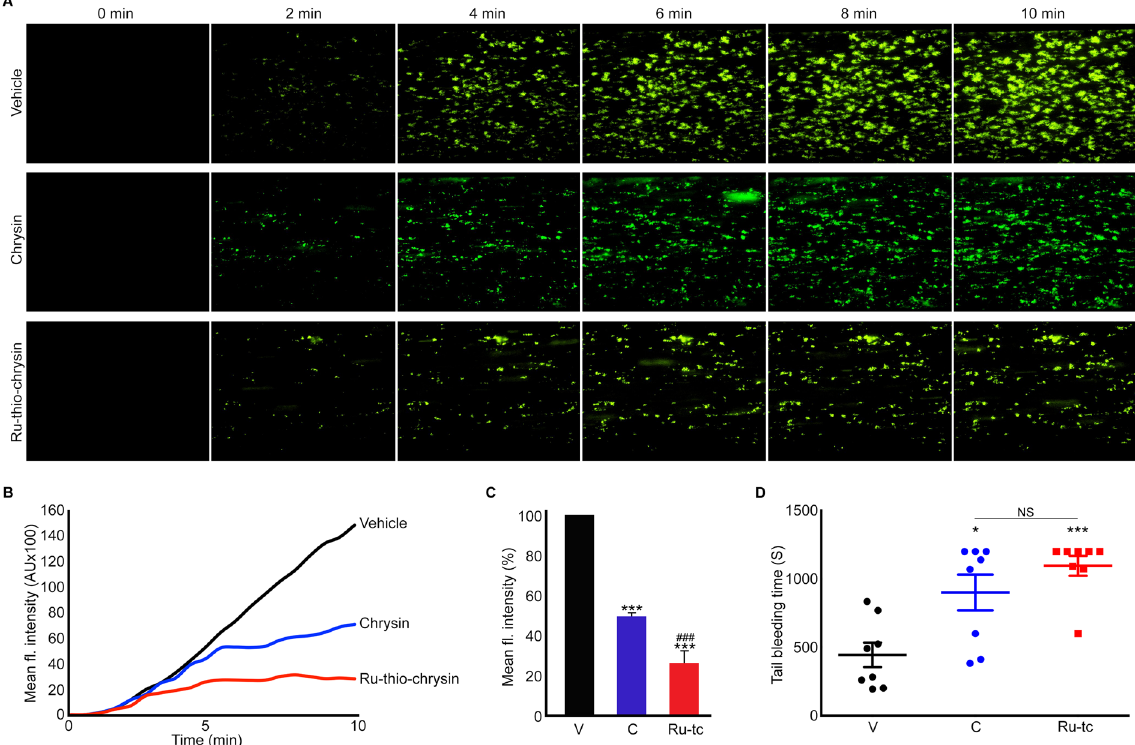
Figure 7. Differential effects of chrysin and Ru-thio-chrysin in the modulation of thrombus formation under arterial flow conditions and haemostasis in mice. DiOC6-labelled human whole blood was treated with vehicle control [0.1% (v/v) DMSO] or 100 μ M chrysin or Ru-thio-chrysin for 5 minutes prior to the perfusion over collagen-coated Vena8 biochips. Thrombus formation was monitored by capturing Z-stack fluorescent images at every 30 seconds over 10 minutes by fluorescence microscopy. The images shown ( A ) at different time points and traces ( B ) are representative of three separate experiments. ( C ) The mean fluorescence intensity obtained with vehicle control (V) at 10 minutes was taken as 100% to calculate the level of inhibition in chrysin (C) and Ru-thio-chrysin (Ru-tc)-treated samples. Data represent mean ± S.D. (n = 3). * Indicates significance with respect to control and # indicates significance with respect to the respective chrysin concentration; p values shown ( *** ,### p < 0.001) are as calculated by one-way ANOVA using Graphpad Prism. ( D ) The effects of vehicle control [0.1% (v/v) DMSO] or 25 μ M of chrysin (C) or Ru-thio-chrysin (Ru-tc) in the modulation of haemostasis were analysed by tail bleeding assay in mice. Data represent ± S.D. (n = 8 mice in each group). The p values shown ( * p < 0.05 and *** p < 0.001) are as calculated by non-parametric Mann-Whitney test using Graphpad